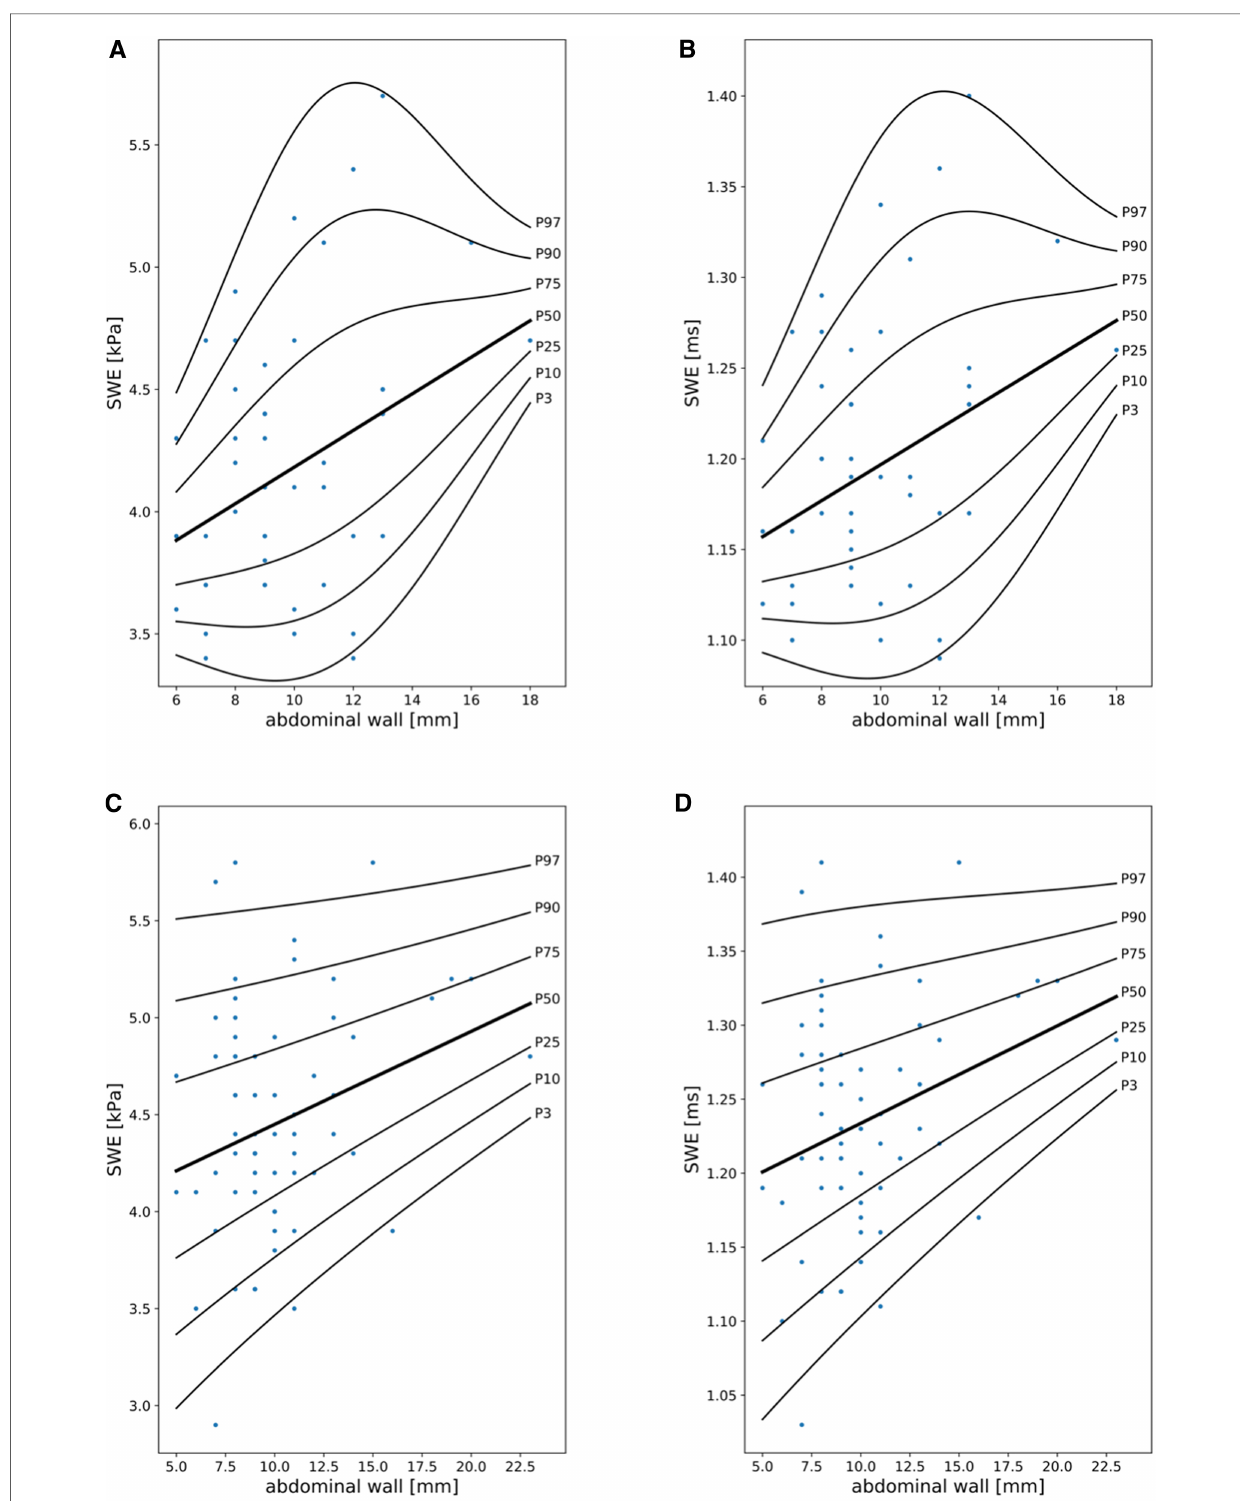
FIGURE 2 Shear wave elastography (SWE) reference curves in girls ( A,B ) and boys ( C,D ) in kPa and ms in relationship to abdominal wall thickness